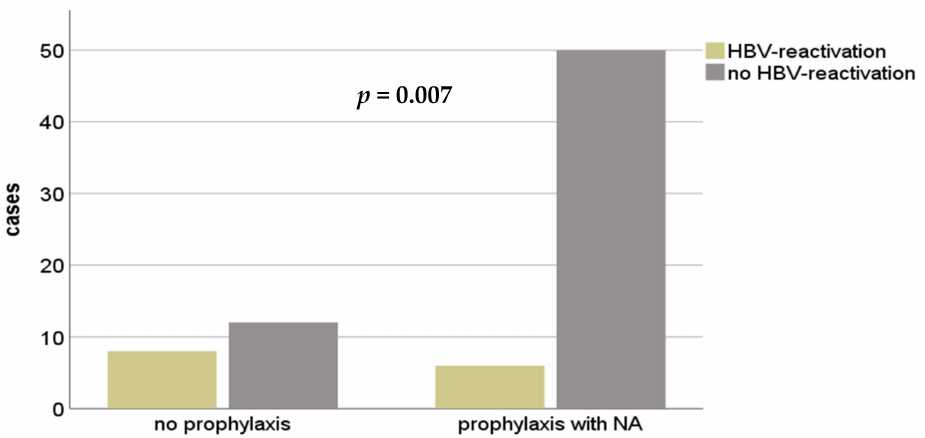
Figure 4. Recurrent HBV-infection in patients after HBcAb+ LT with or without a prophylactic therapy. NA—nucleos(t)ide analog; HBV—hepatitis B Virus; HBcAb—hepatitis B core